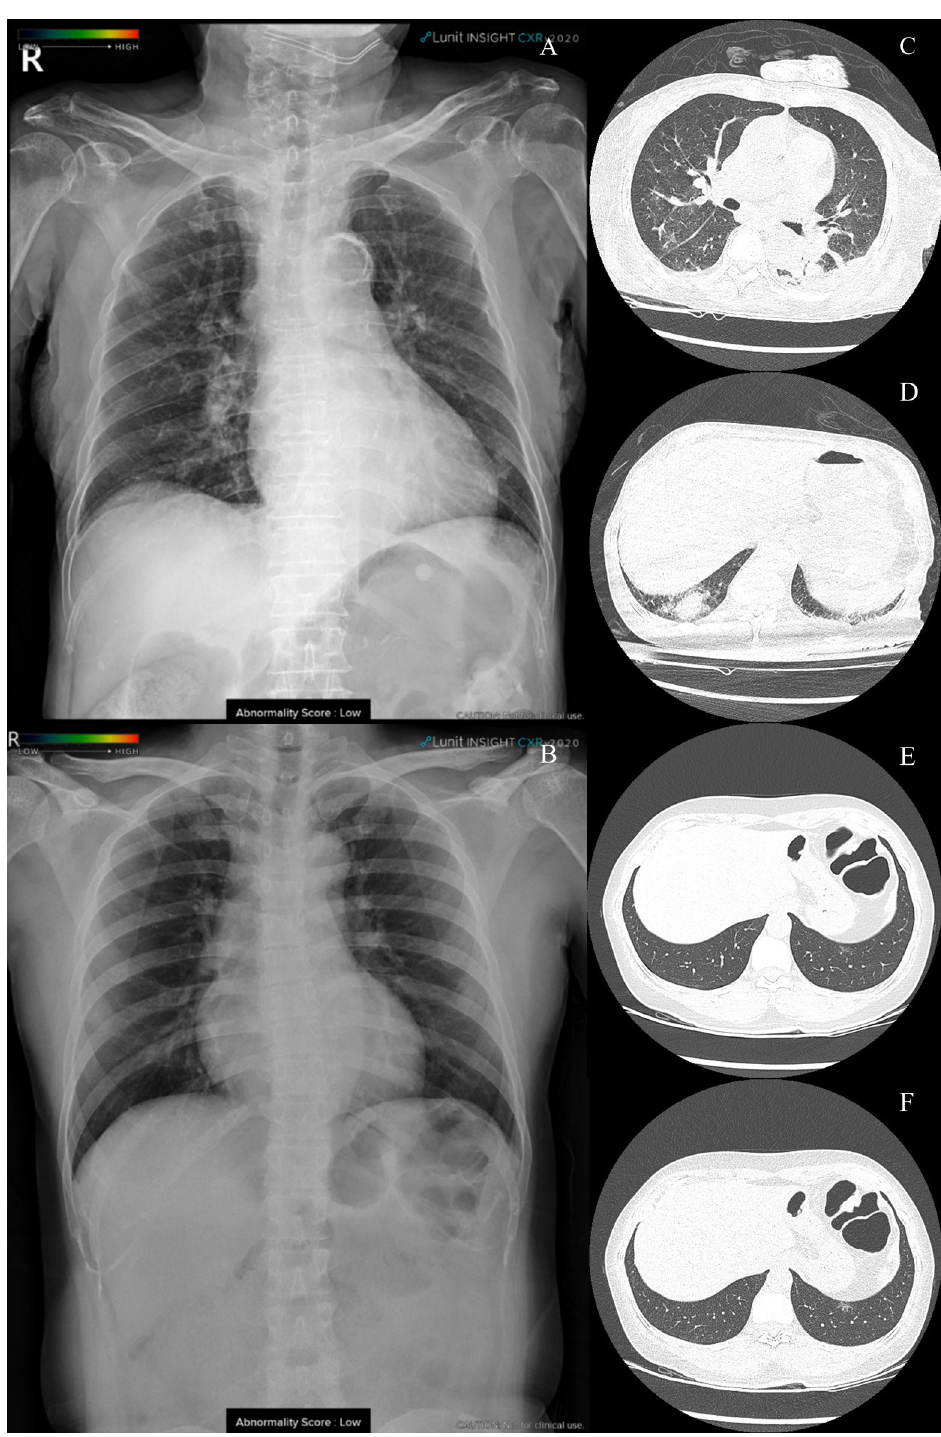
Fig 4. False-negative interpretations of DL algorithm. (A, B) DL algorithm classified chest radiography as negative for pneumonia. Chest computed tomography scans show (C) focal GGOs in the right middle lobe, (D) multifocal consolidations in the right lower lobe, and (E, F) small amounts of